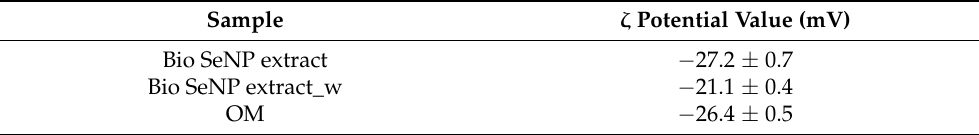
Table 2. Surface charges of biogenic